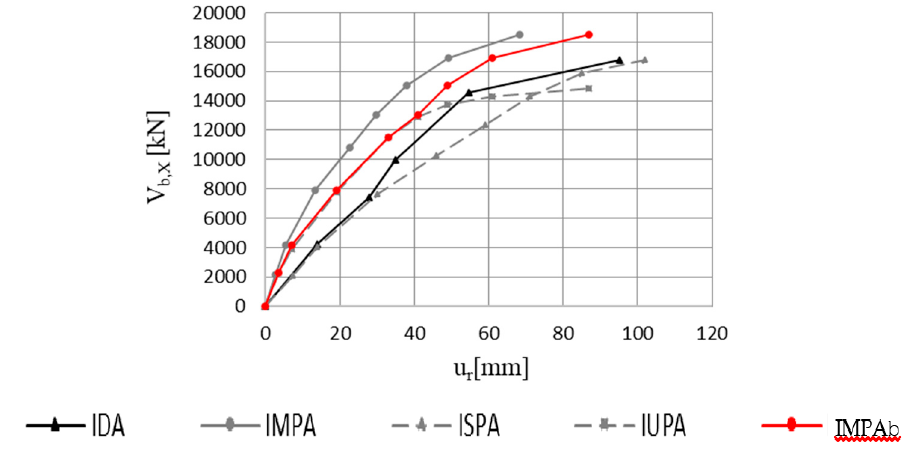
Figure 17. Comparison of the incremental curve and capacity curves obtained according to different procedures (maximum values of u r and Vb,x).